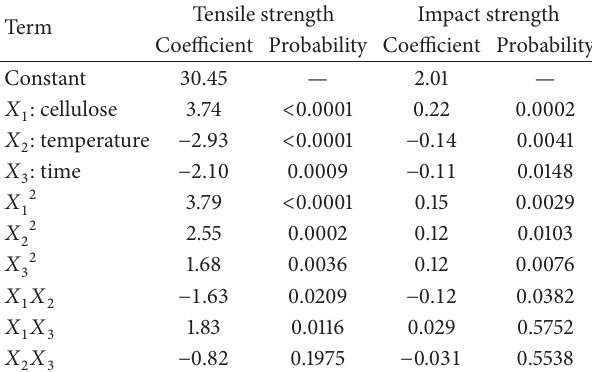
Table 6: Regression coefficients and probability values of approxi- mate polynomials for response variables in experimental